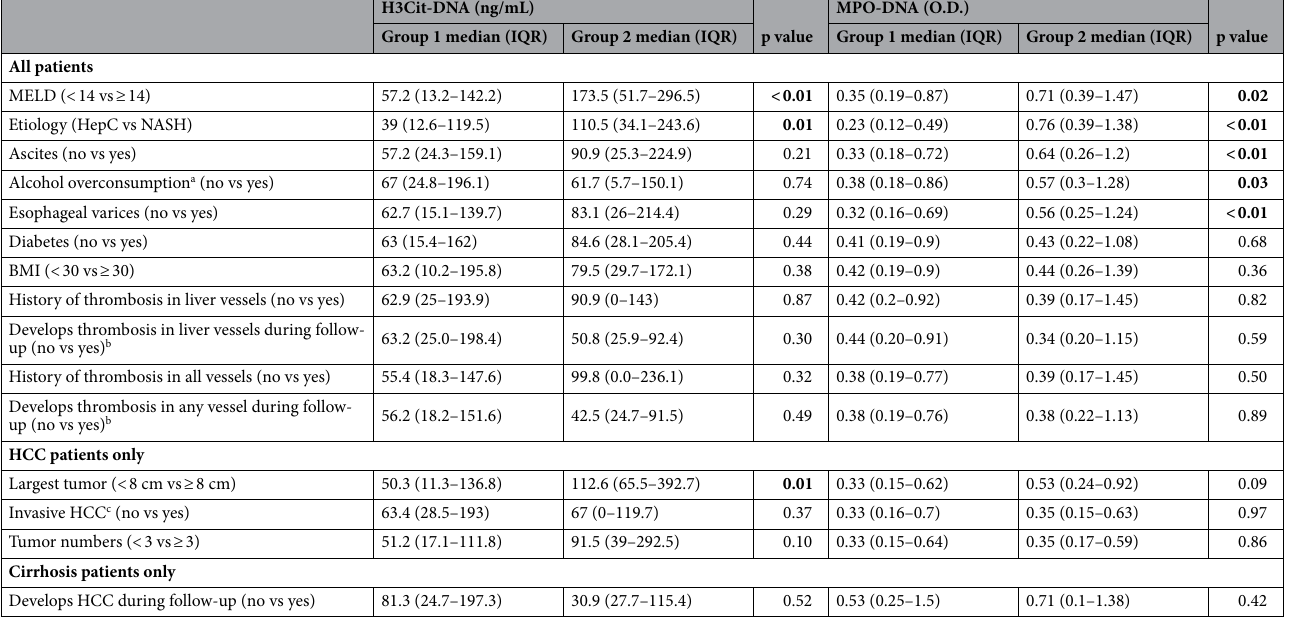
Table 2. H3Cit-DNA levels (ng/mL) and MPO-DNA levels (O.D.) in patients stratified on various clinical variables. Median follow-up for the evaluation of thrombosis development was 22.5 months, and 26 months for HCC development in patients with cirrhosis. a Alcohol overconsumption defined as ≥ 14 units/week (males) or ≥ 10 units/week (females) or diagnosis of alcoholic liver disease in medical charts. b Patients with a history of same type thrombosis are excluded. c Macrovascular invasion or extrahepatic spread at time of inclusion. Extrahepatic spread includes lymph node invasion and distant metastases.